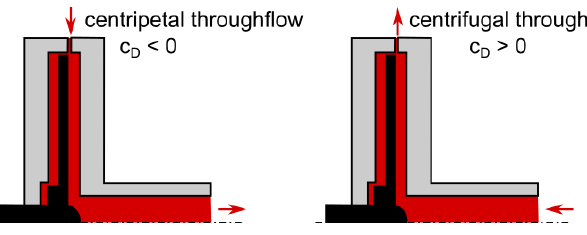
Figure 14. Centripetal vs centrifugal